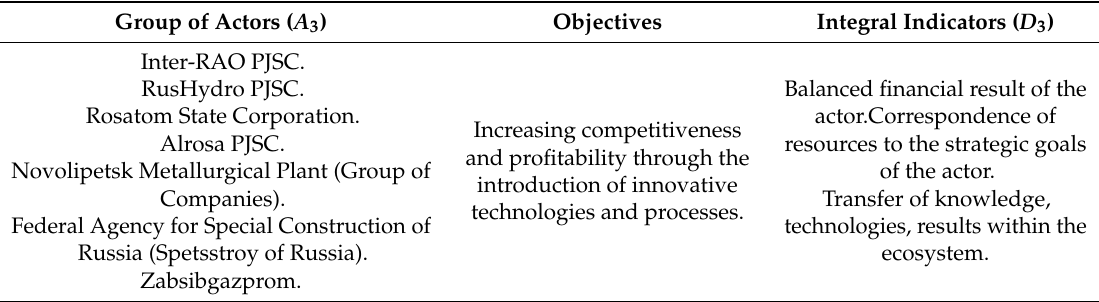
Table 4. Characteristics of actors—customers /